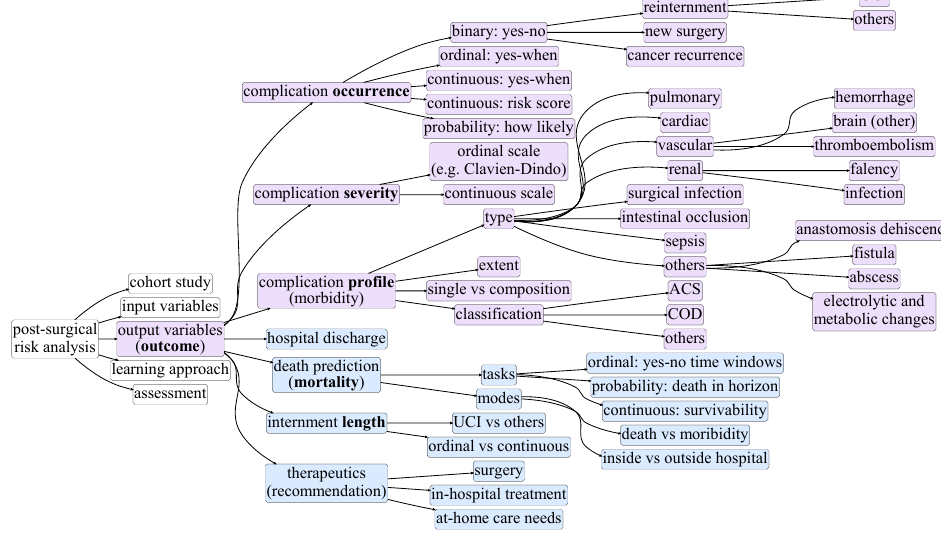
Figure 4. Taxonomy for postsurgical risk analysis: postsurgical outcomes ( output